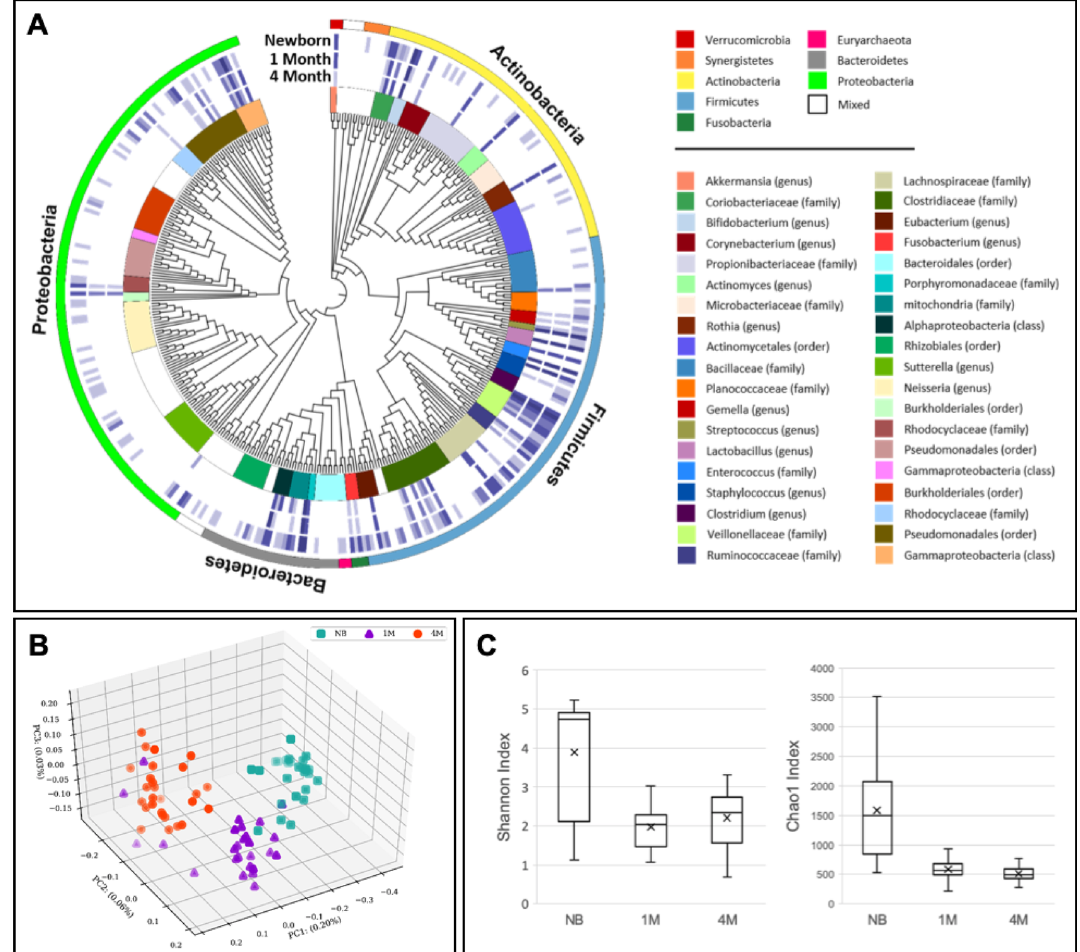
Figure 1. Differences in the fecal microbial communities of newborns, 1 M and 4 M infants. ( A ) Representative commensal gut microbial community in infants during first 4 months. The colored blocks outermost indicate phyla and the heatmap circles show absolute abundances of each OTUs in the newborns, 1-month-old and 4-month-old infants. The innermost neighbor-joining phylogenetic tree containing one representative of each of the OTUs. ( B ) PCoA analysis plot based on unweighted UniFrac distances, each point represents the microbiota of a single sample, and colors reflect metadata for that sample. ( C ) Comparison of bacterial diversity across sample groups in Shannon’s diversity index and Chao1